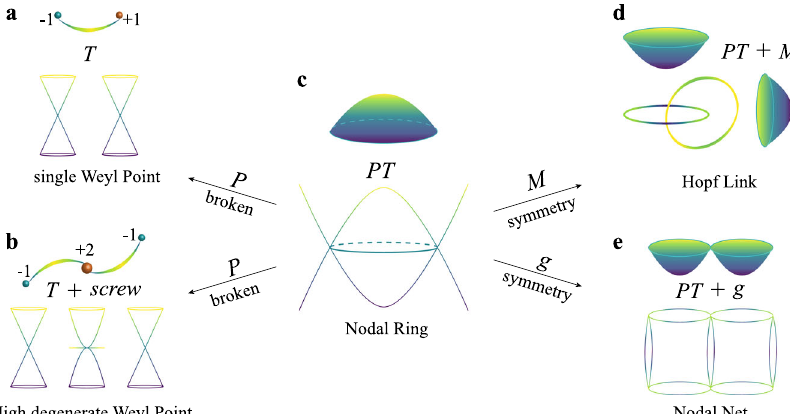
Fig. 6 The schematic relations between different types of TPs. a Single Weyl TPs in the open arc states. b High degenerate Weyl TPs in the arc surface states. c Nodal-ring (line) TPs in drumhead-like surface states. d Hopf-link TPs in nontrivial surface states. e Nodal-net TPs (e.g., HNN) and their corresponding drumhead-like